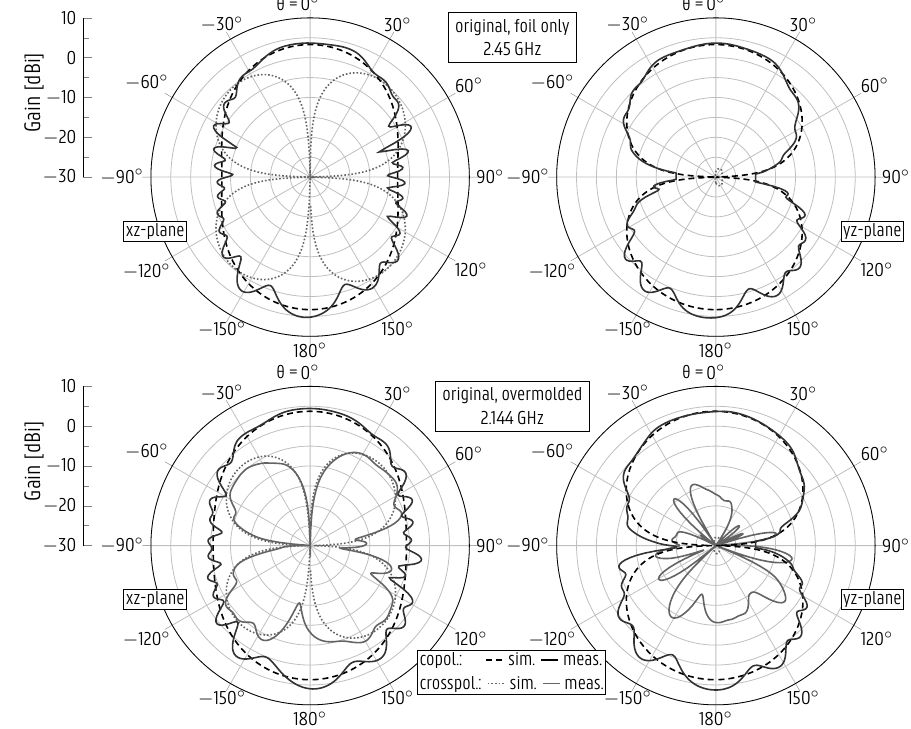
Figure 9. Simulated and measured radiation patterns of the original coplanar patch antenna, stand- alone printed on plastic foil ( top ) and after overmolding ( bottom